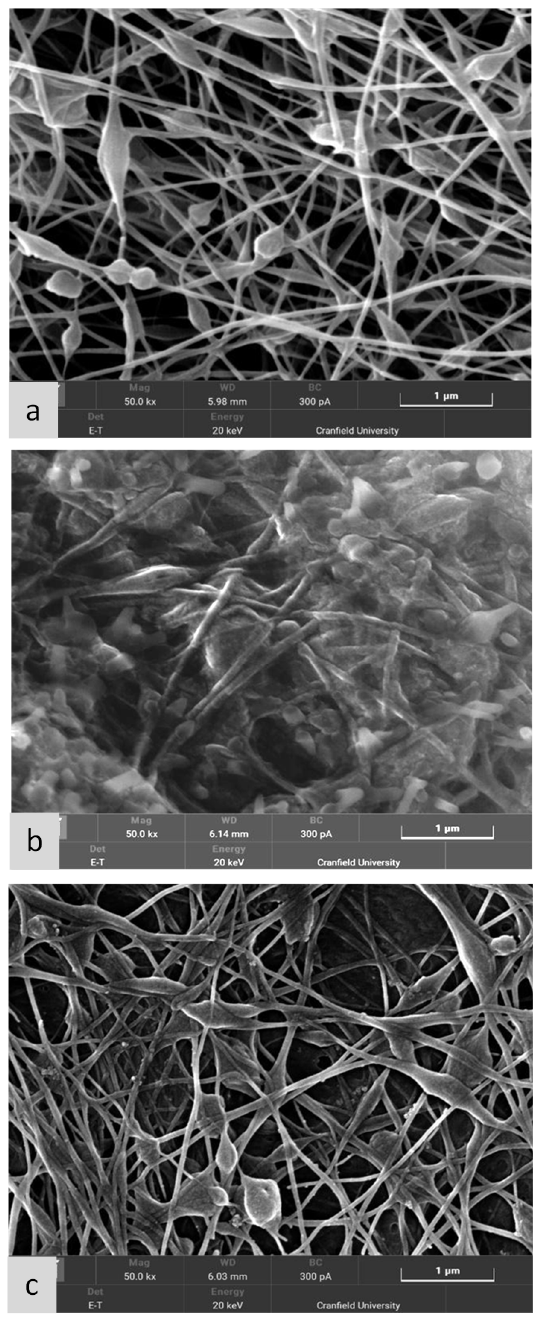
Figure 8. SEM of different samples with and without crosslinking: ( a ) S4—without crosslinking; ( b ) S5—after crosslinking with CaCl 2 , and ( c ) S6—after crosslinking with calcium chloride and water soak procedure for 24 h.